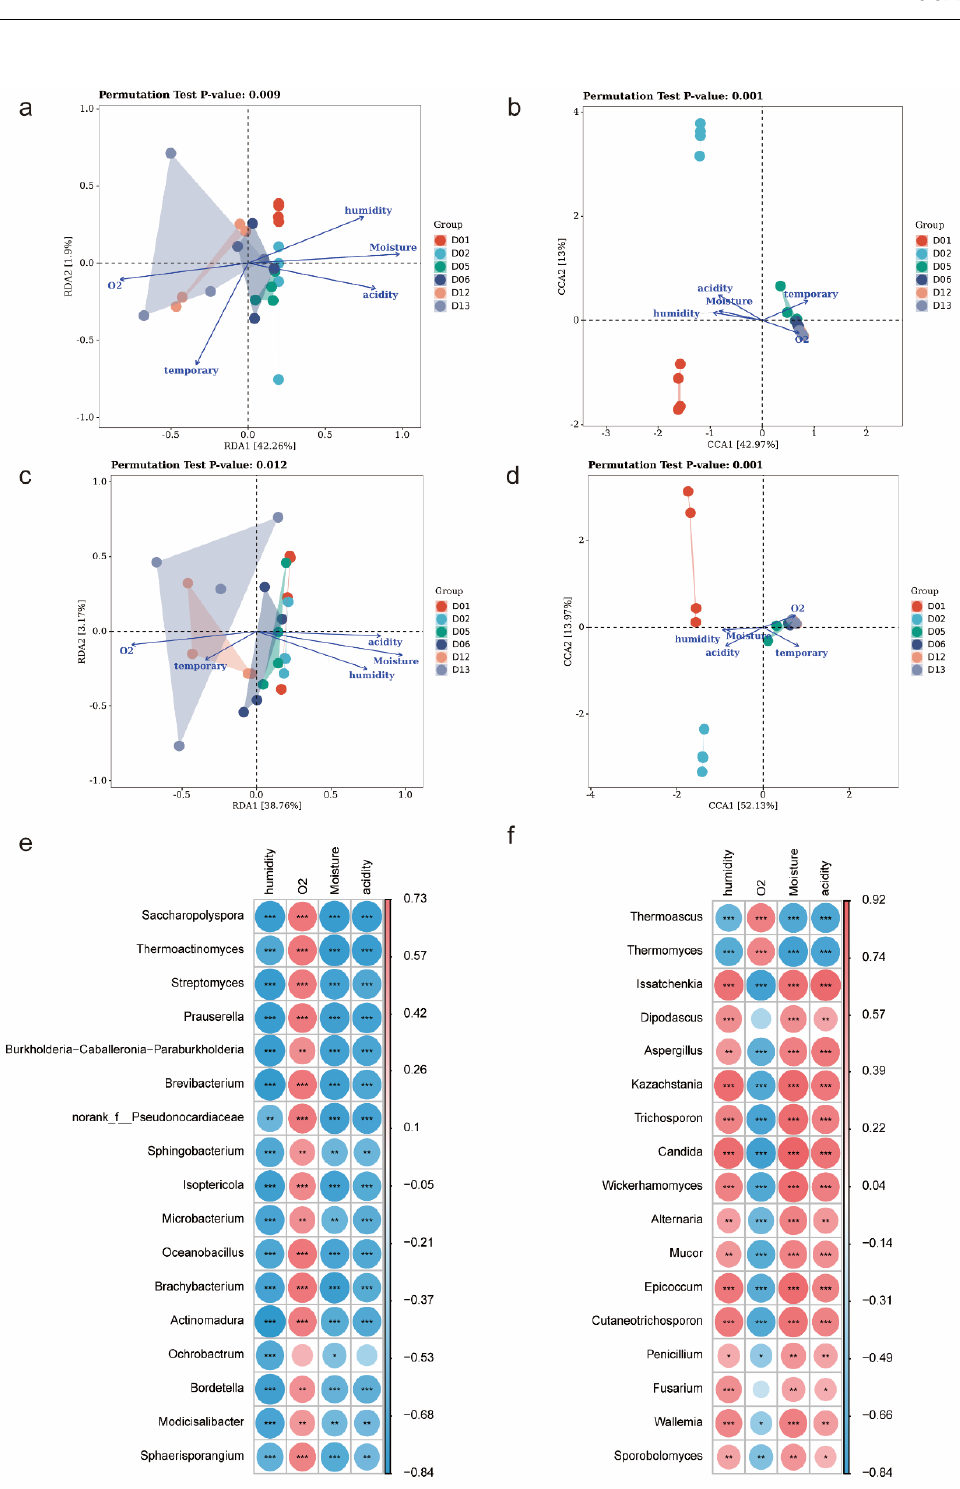
Figure 3. Effects of environmental factors on functional microbial communities. The effects of envi- ronmental factors on AFBM ( a ), AFFM ( b ), FFBM ( c ), and FFFM ( d ) were studied using RDA/CCA. The length of the arrow represents the size of the effect of environmental factors on the distribution of species in the sample. Heatmap of the association between environmental factors and functional microbiota. Bacterial genera ( e ), fungal genera ( f ). Red represents positive correlation, blue rep- resents negative correlation, and the degree of correlation is proportional to the size of the